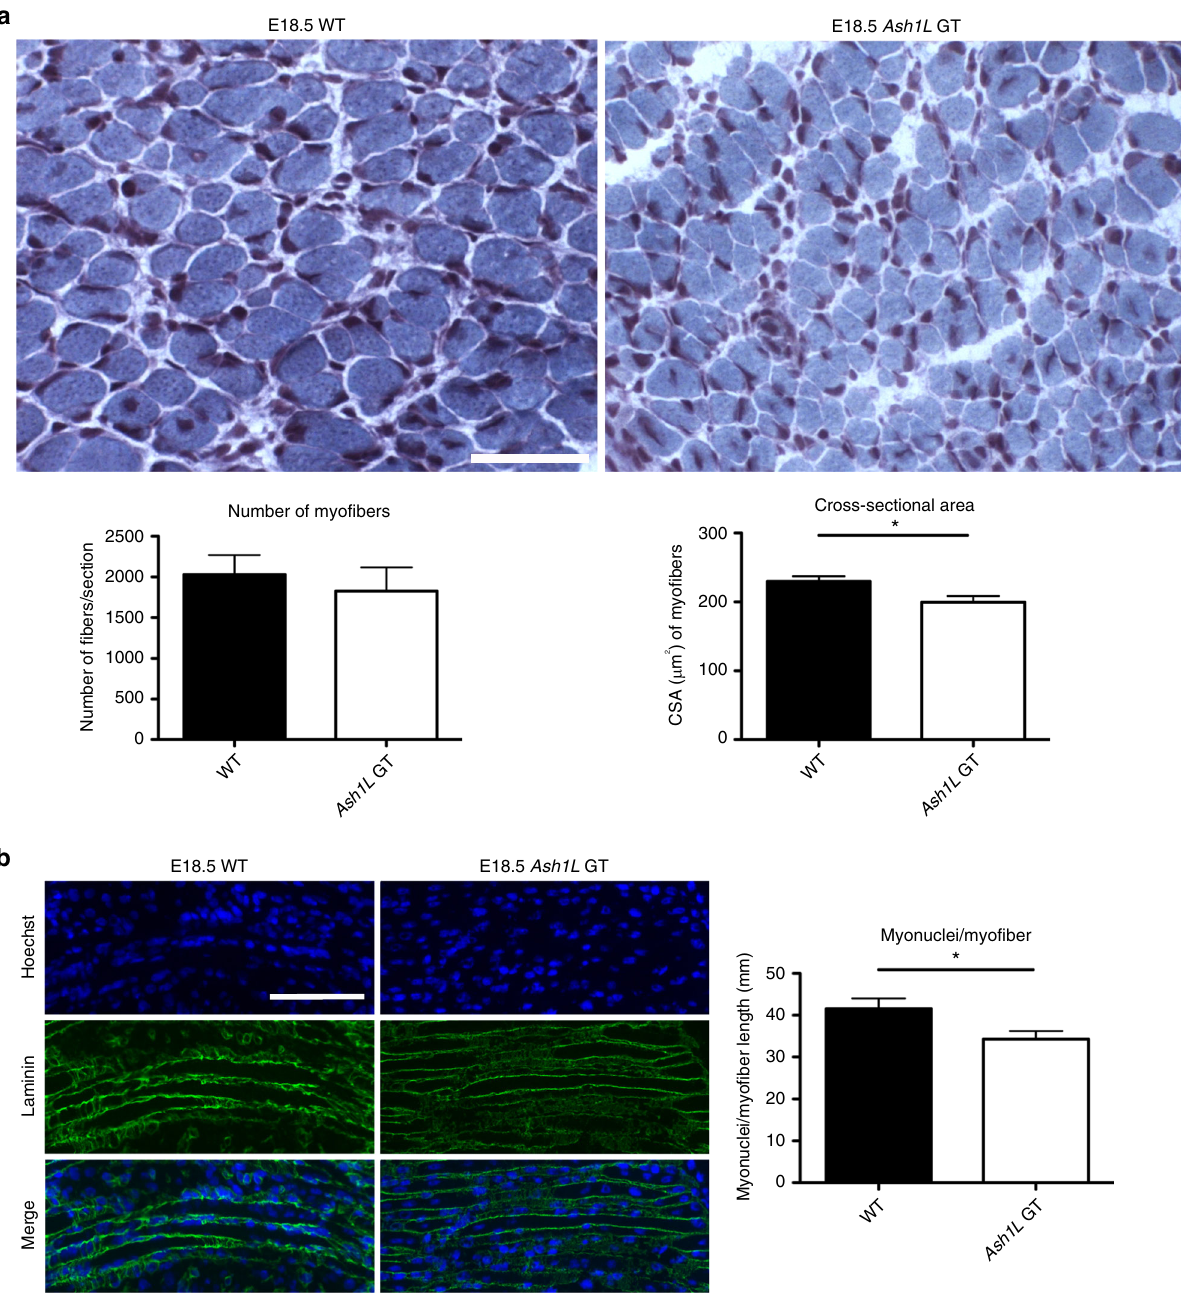
Fig. 2 Ash1L GT mice display muscle hypoplasia. a Gomori-trichrome staining of transverse cryosections from wild-type (WT) and Ash1L GT mice, at embryonic stage E18.5 (upper panel). Quanti fi cation of: the total number of myo fi bers and myo fi bers cross-sectional area (CSA) (lower panel). n = 3. Scale bar, 100 µ m, magni fi cation ×20. Unpaired two-tailed t test. Con fi dence intervals 95%. Results come from six biological replicates. b Immuno fl uorescence for laminin (in green) and nuclear staining (Hoechst) in longitudinal cryosections from wild-type (WT) and Ash1L GT mice, at the embryonic stage of E18.5 (left panel). Quanti fi cation of the number of myonuclei normalized on myo fi ber length in mm (myonuclei/myo fi bers) (right panel). Scale bar, 100 µ m, magni fi cation ×20. Unpaired two-tailed t test. Con fi dence intervals 95%. Results come from seven biological replicates. Source data are provided as a Source Data fi le. * p ≤